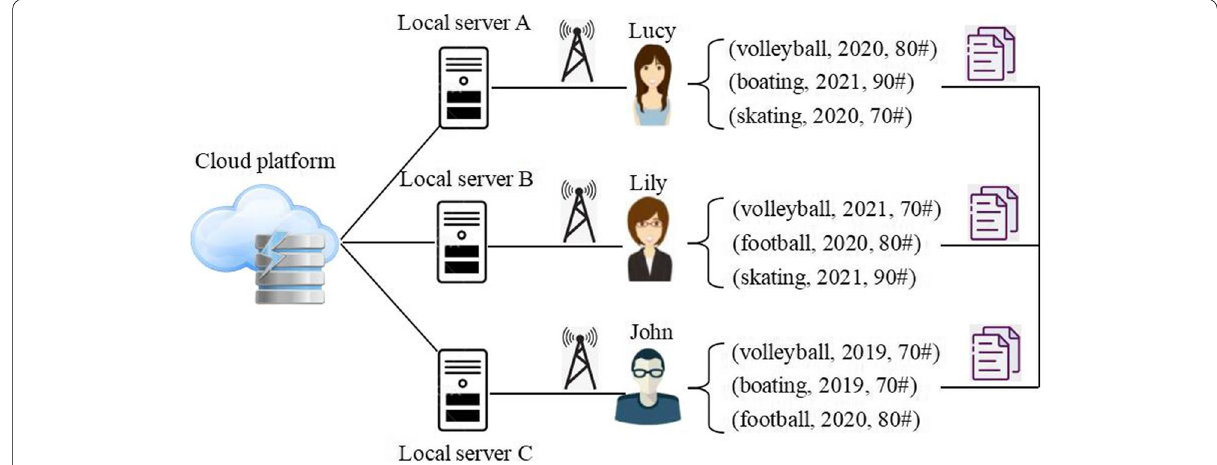
Fig. 1 An integration framework of sport-time-score records in cloud